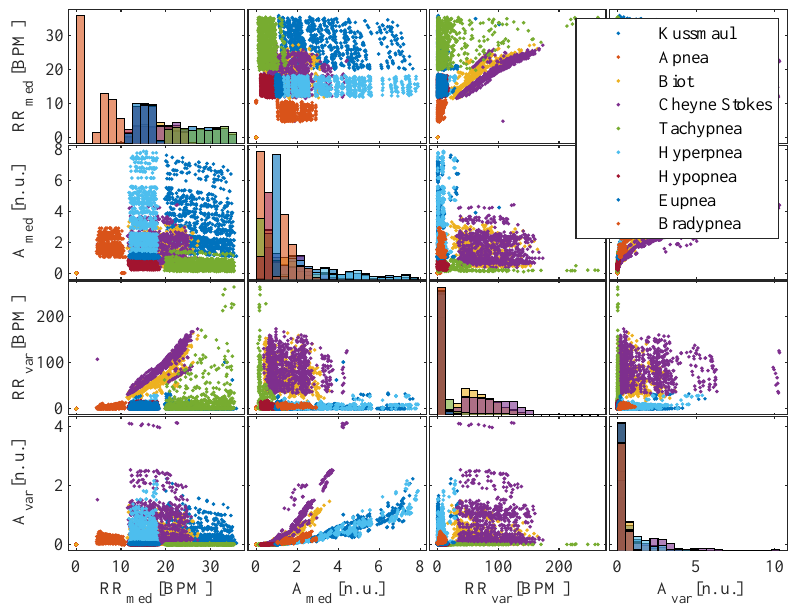
Figure 12. Scatter plots for all extracted respiratory feature combinations.